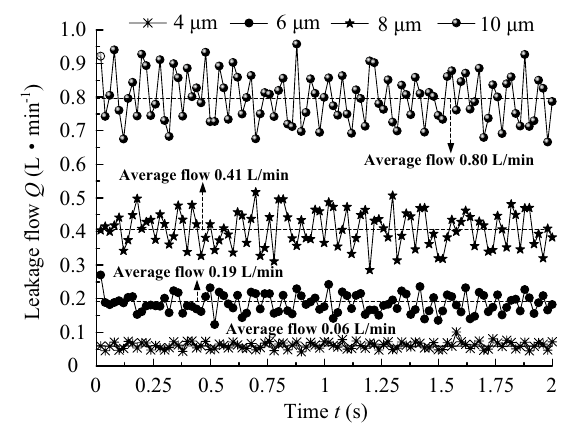
Figure 11 Leakage flow of port plate pairs at various water film